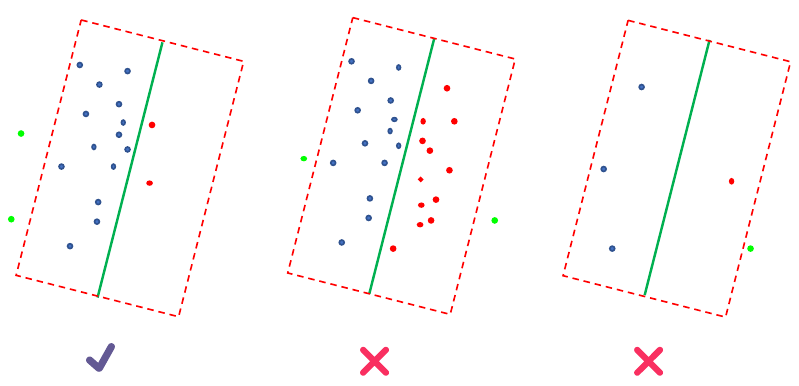
Figure 2. Three common situations when filtering line segments. Line segments are represented by green line. Search bounding boxes are red. Points of facet outside bounding box are green. Points located inside bounding box are participated into x neg and positive x pos and displayed in red and blue, respectively. The left situation meets the reservation condition. In the middle situation, ) < 2. In the right situation, x neg + x pos < τ max ( x neg , x pos x pos x neg